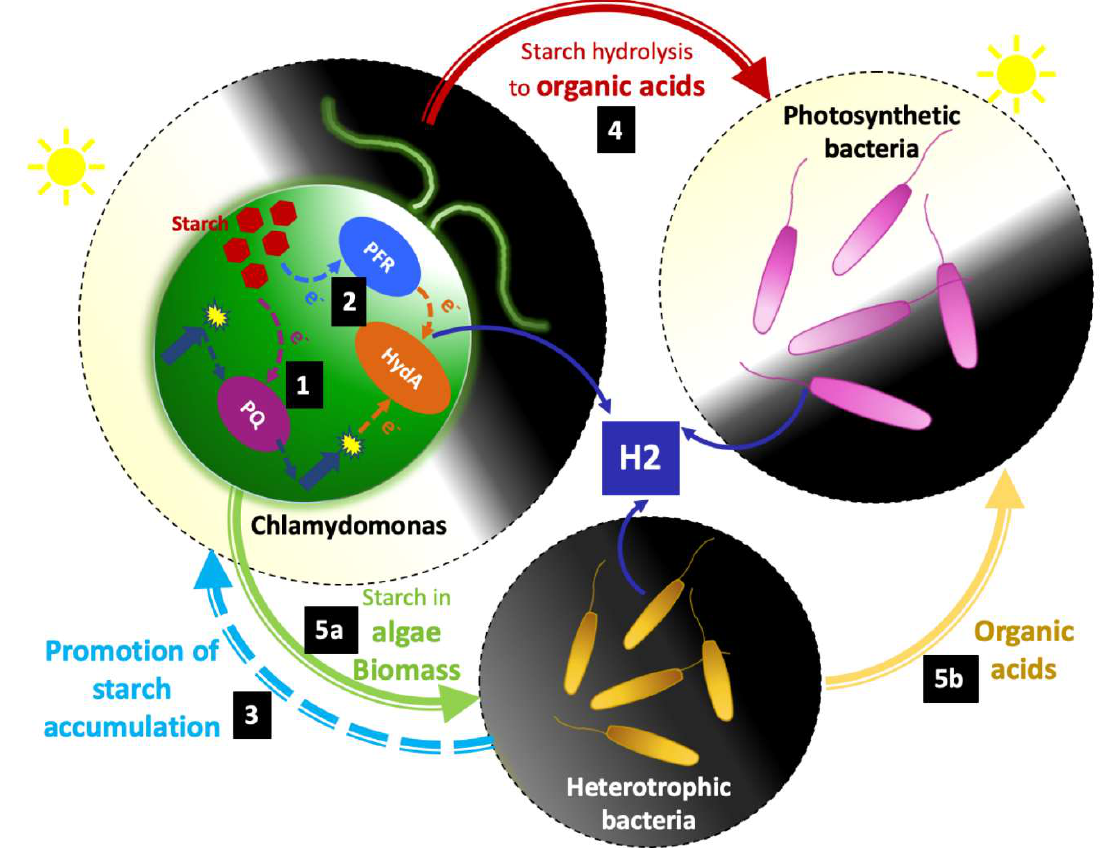
Figure 1. Potential starch-derived relationships between Chlamydomonas and other microorganisms during H 2 production. Starch accumulated in Chlamydomonas cells can be used to feed the PII-independent ( 1 ) and fermentative ( 2 ) pathways. The accumulation of starch in Chlamydomonas can be favored when co-cultured with some bacterial strains ( 3 ). Different end products derived from Chlamydomonas starch mobilization can be excreted and used by Purple Non-Sulfur Photosynthetic (PNSP) bacteria for H 2 production ( 4 ). Starch-enriched Chlamydomonas biomass can be used directly by some heterotrophic bacteria to produce H 2 ( 5a ) or in collaboration with PNSP bacteria ( 5b ). Pyruvate Ferredoxin Reductase (PFR); PlastoQuinone (PQ); hydrogenase A (HydA).